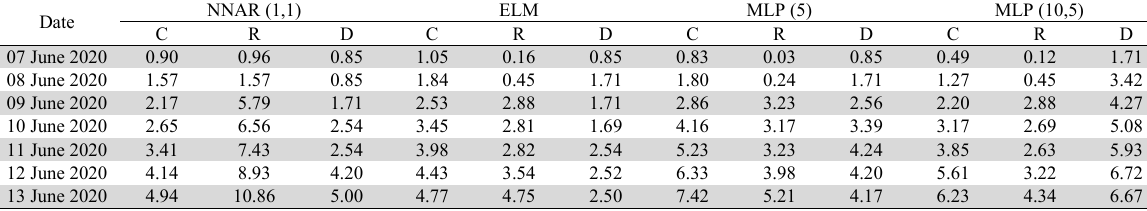
The percentage value of APE tested by using NNAR, ELM, and MLP